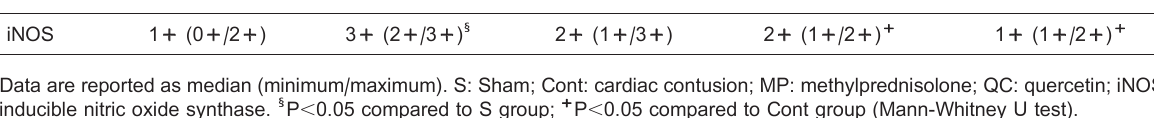
Table 4. Semiquantitative assessment of iNOS positive cells in myocardial tissues of each group. S Cont Cont++MP